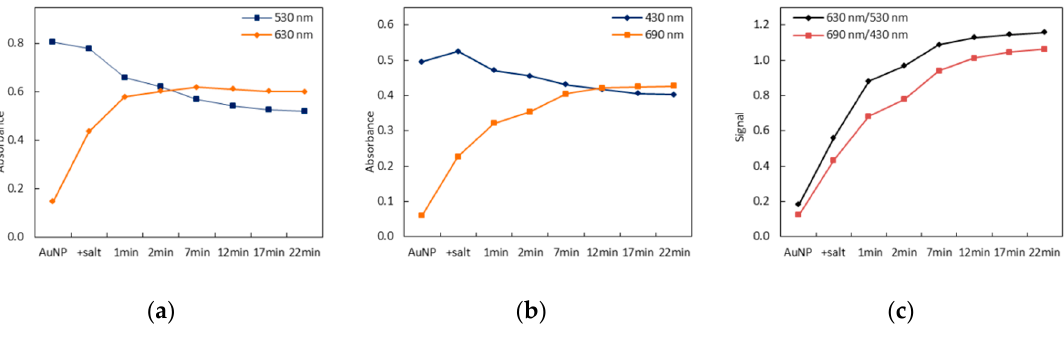
Figure 5. Kinetics of the magnesium salt-induced aggregation of AuNPs. MgCl 2 = 50.0 mM, run-time = 22 min. Selected wavelengths λ 1 = 430 nm and λ 2 = 690 nm ( a ) or λ 1 = 530 nm and λ 2 = 630 nm ( b ); ( c ) ratio of the predetermined wavelengths in terms of λ 2 / λ 1 .